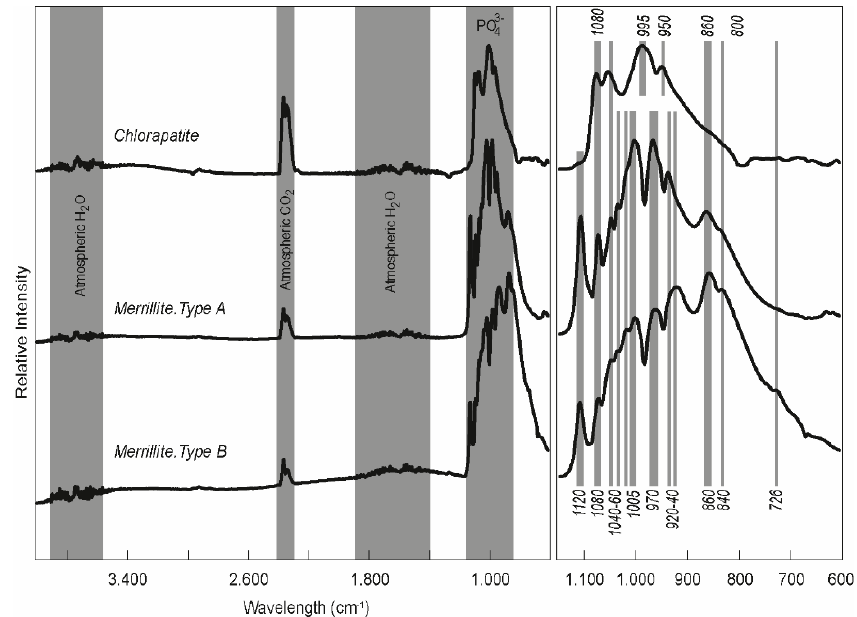
Figure 6. FTIR spectra of chlorapatite and two different types of spectra of merrillite, with bands attributed to atmospheric H 2 O and CO 2 .